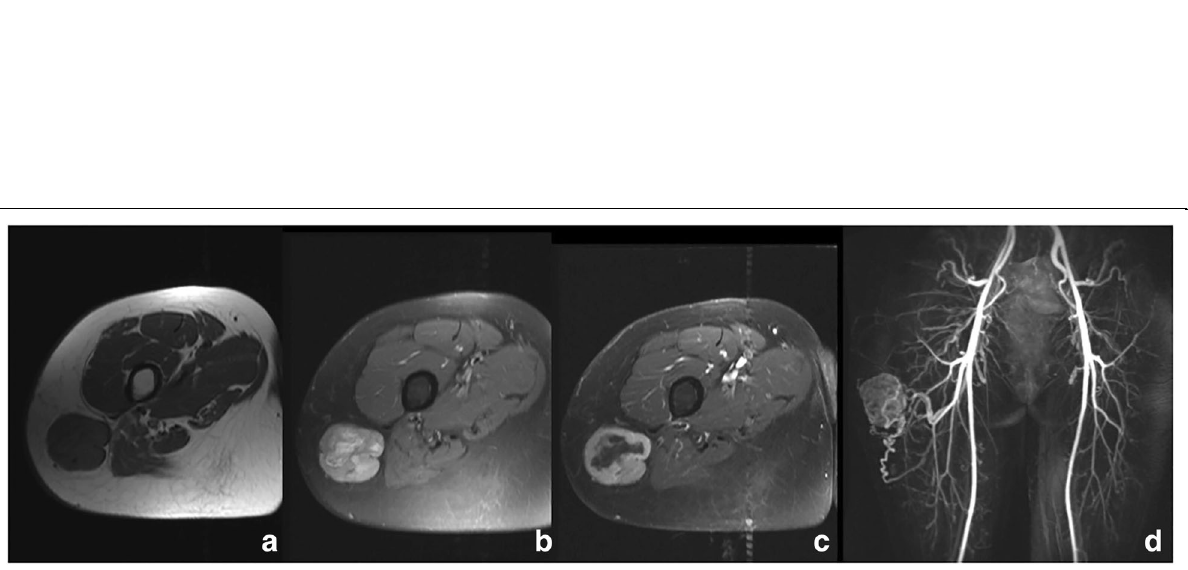
Fig. 12 Axial T1-weighted ( a ) T2-weighted fat saturated ( b ) and contrast-enhanced MR images ( c ) show well-defined, heterogeneously enhancing soft- tissue mass in the lateral compartment of the thigh. TOF sequence MR images ( d ) show the hypervascularity of the lesion, biopsy proven to be a SFT